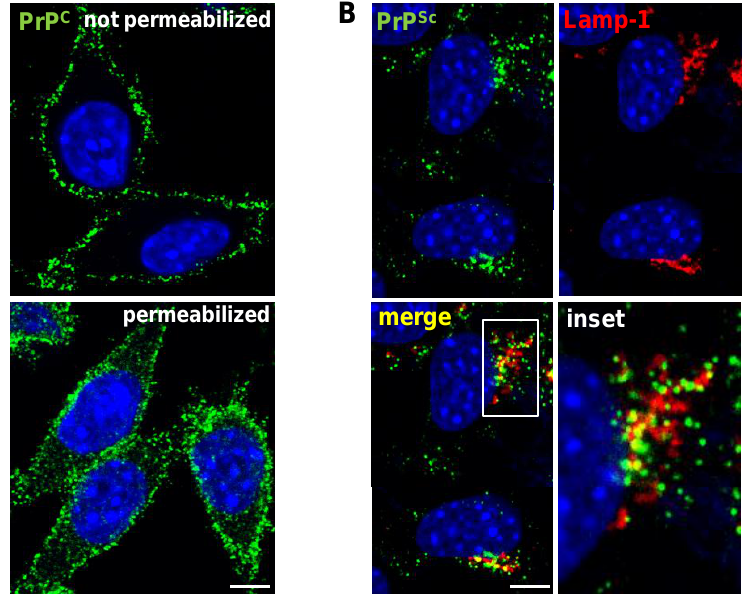
Figure 1. Localization of PrP C and PrP Sc in L929 fibroblast cells. ( A ) Indirect immunofluorescence (IF) staining of cellular PrP (green) in uninfected L929 cells. PrP C predominantly resides at the cell surface with some intracellular localization. ( B ) Detection of PrP Sc in L929 cells persistently infected with prion strain 22L by IF. In contrast to PrP C , PrP Sc (green) primarily localizes intracellularly and partially co-localizes with the lysosomal marker Lamp-1 (red). ( A,B ) Nuclei were counterstained with Hoechst (blue). Scale bar: 5